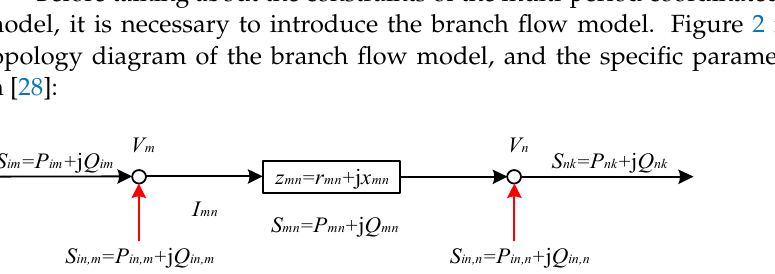
Figure 2. Branch flow model of distribution network.